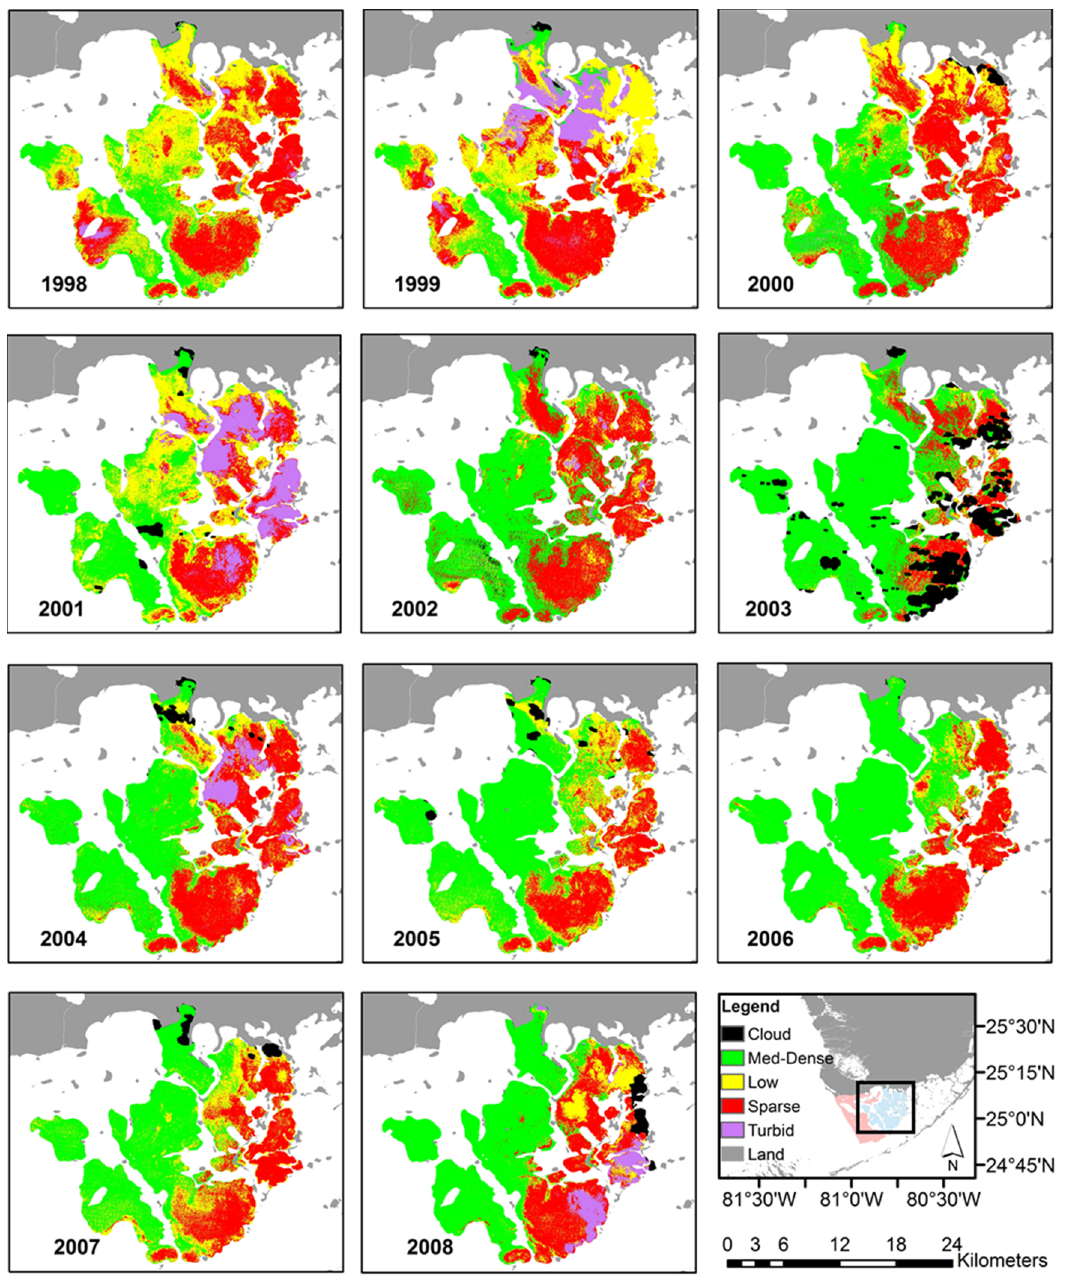
Figure 5. Seagrass cover mapping products for 1998 to